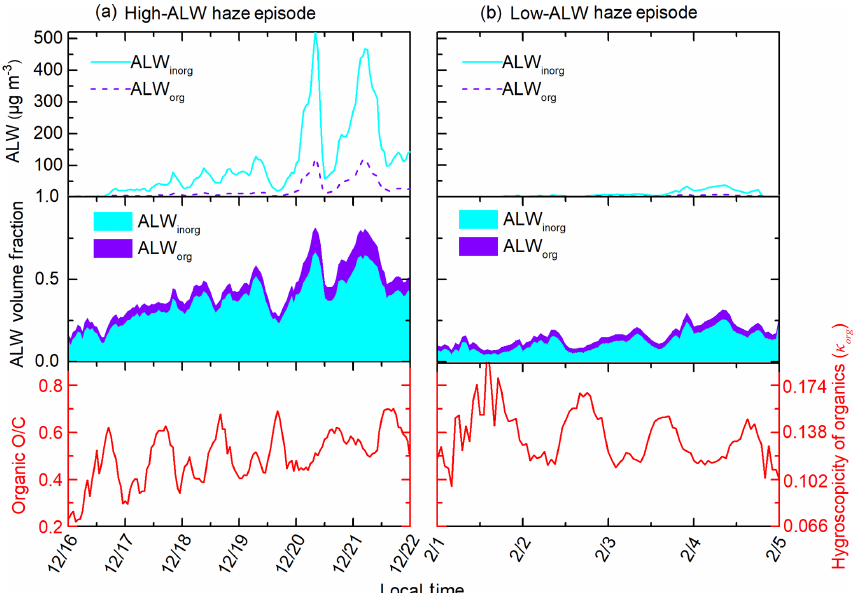
Figure 4. Variations in aerosol liquid water contributed by organics (ALW org ), aerosol liquid water contributed by inorganics (ALW inorg ), the volume fraction of total wet particle compositions, and organic O / C during (a) a typical high-ALW episode and (b) a typical low-ALW episode.